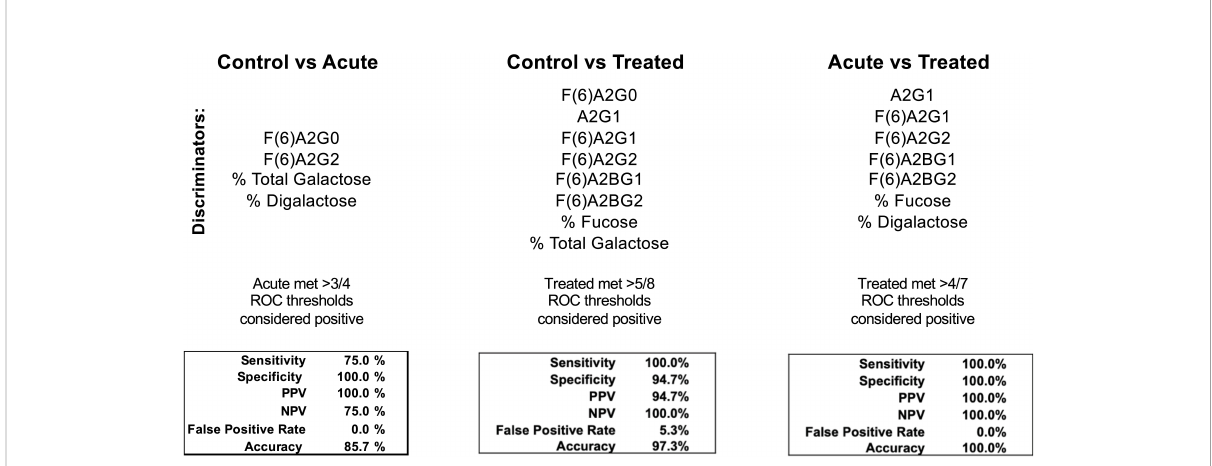
FIGURE 4 Confusion matrices from combined discriminatory IgG N-glycan ROC thresholds. N-glycans with signi fi cant discrimination between cohorts determined using ROC analysis are listed above. The listed N-glycan discriminators were combined for each cohort comparison (Control vs Acute LD, Control vs Treated LD, Treated vs Acute LD) and the resulting confusion matrices are